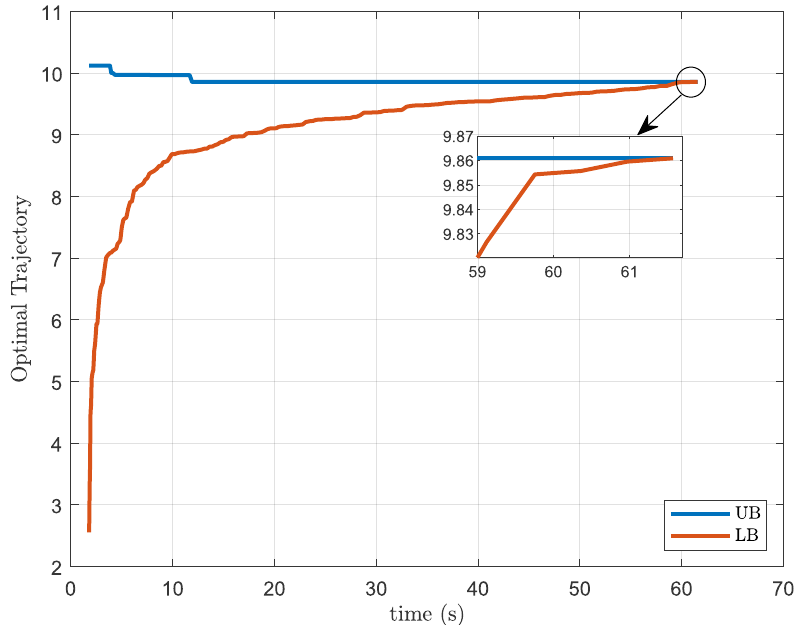
Figure 3. Trajectory of the bounds induced by the Outer Approximation solution, for problem M = 8 and T =